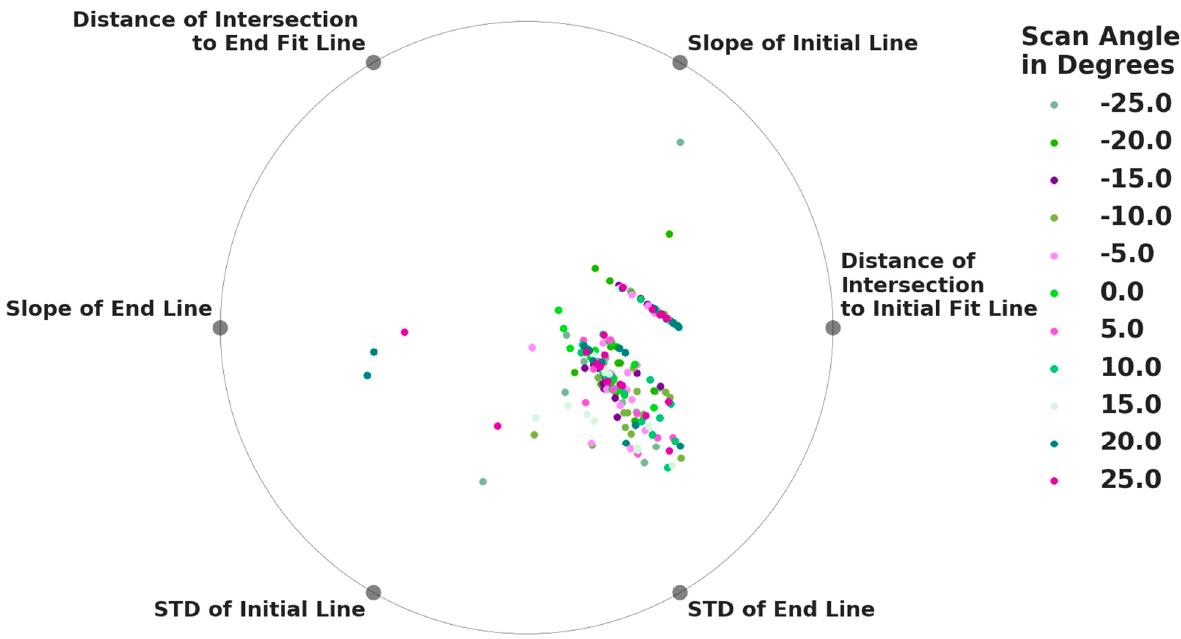
Figure 13. RadViz of parameters for each test, separated by material.